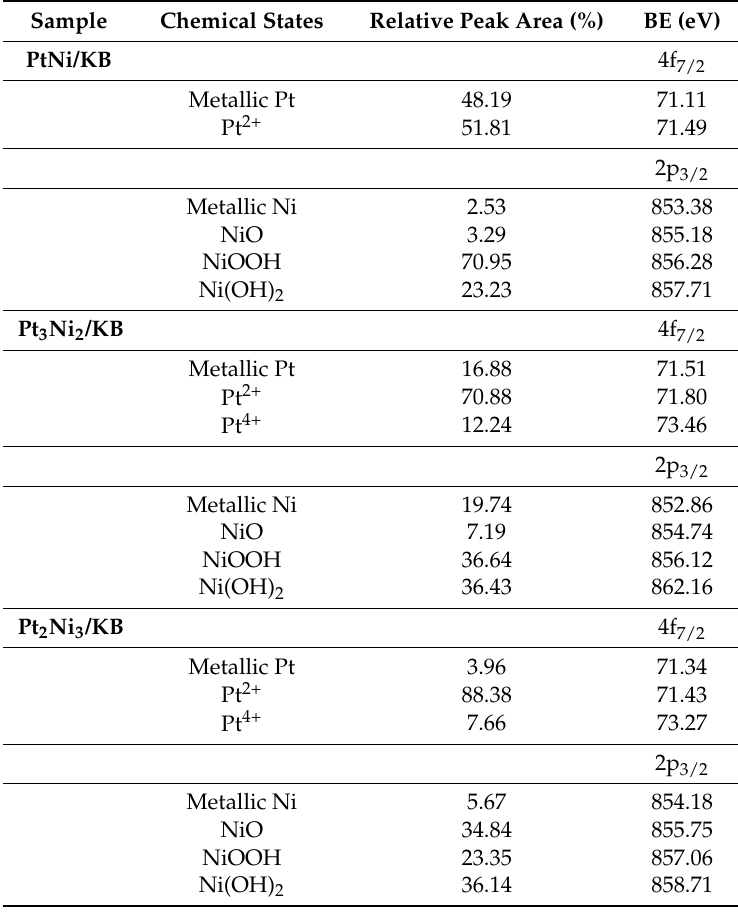
Table 2. Physico-chemical properties of prepared